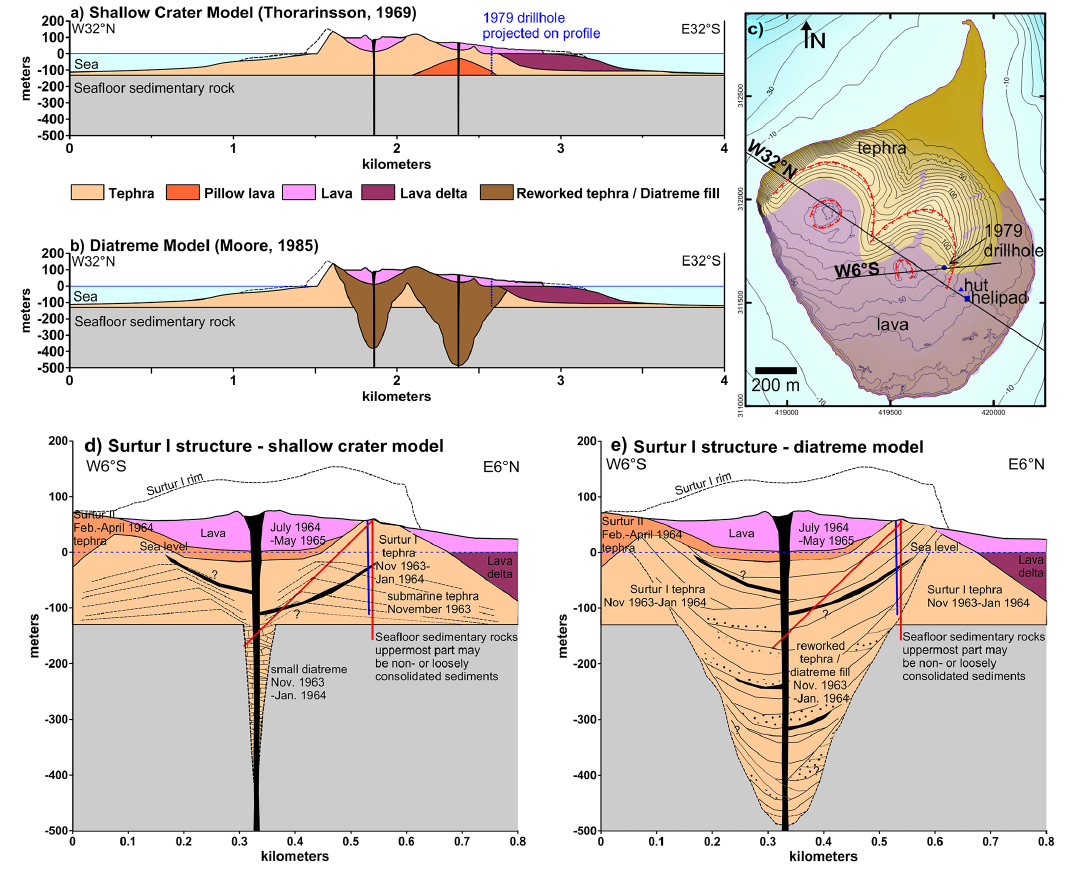
Figure 4. Structural models of Surtsey, showing the shallow crater hypothesis (a, d) (Thórarinsson, 1969) and the diatreme hypothesis (b, e) (Moore, 1985). Red lines on (d) and (e) show the planned drill holes. Although the occurrence of a layer of pillow at the bottom of the formation cannot be ruled out (model shown in a ), no pillow mound is included in (d) as neither was it detected in the 1979 drill hole nor in gravity modeling (Thorsteinsson and Gudmundsson, 1999). The geological map of Surtsey (c) shows the helipad, the Pálsbær II hut, and 1979 drill